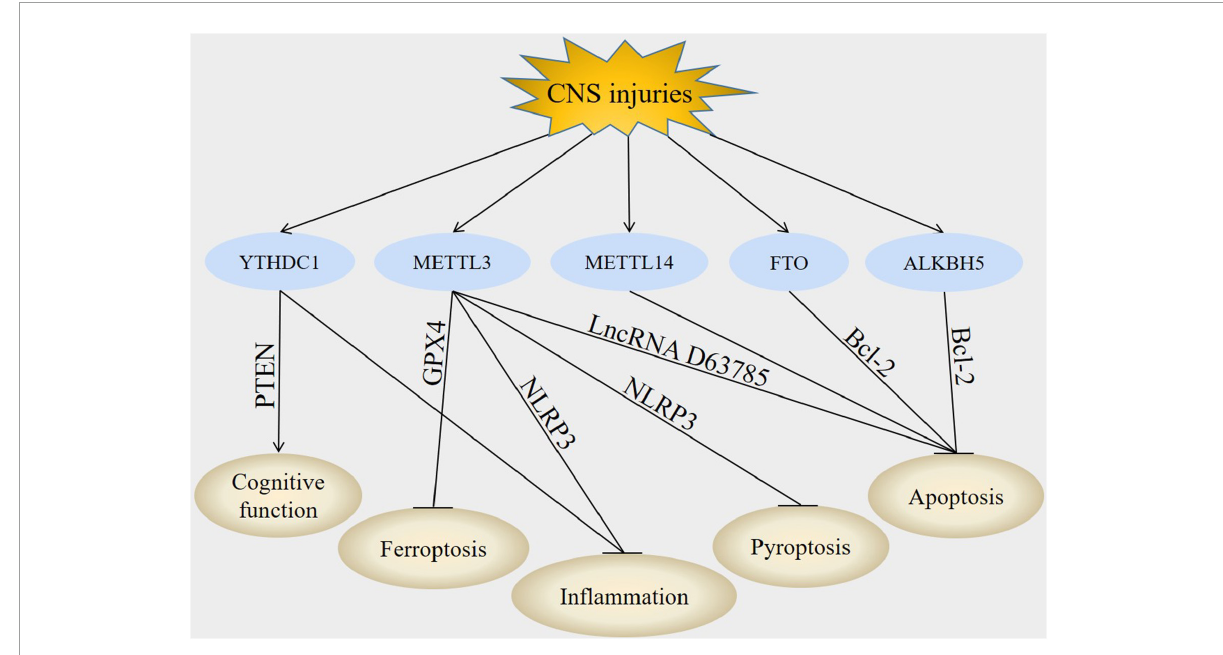
FIGURE2 Downstream molecules of m6A modification in CNS injuries. In CNS injuries, regulation of YTHDC1, METTL3, METTL14, FTO, and ALKBH5 led to the modulation of PTEN, GPX4, NLRP3, lncRNA D63785, and Bcl-2. These downstream molecules subsequently improved cognitive function, inhibited inflammation, suppressed apoptosis, decreased pyroptosis and attenuate ferroptosis post-CNS injuries.